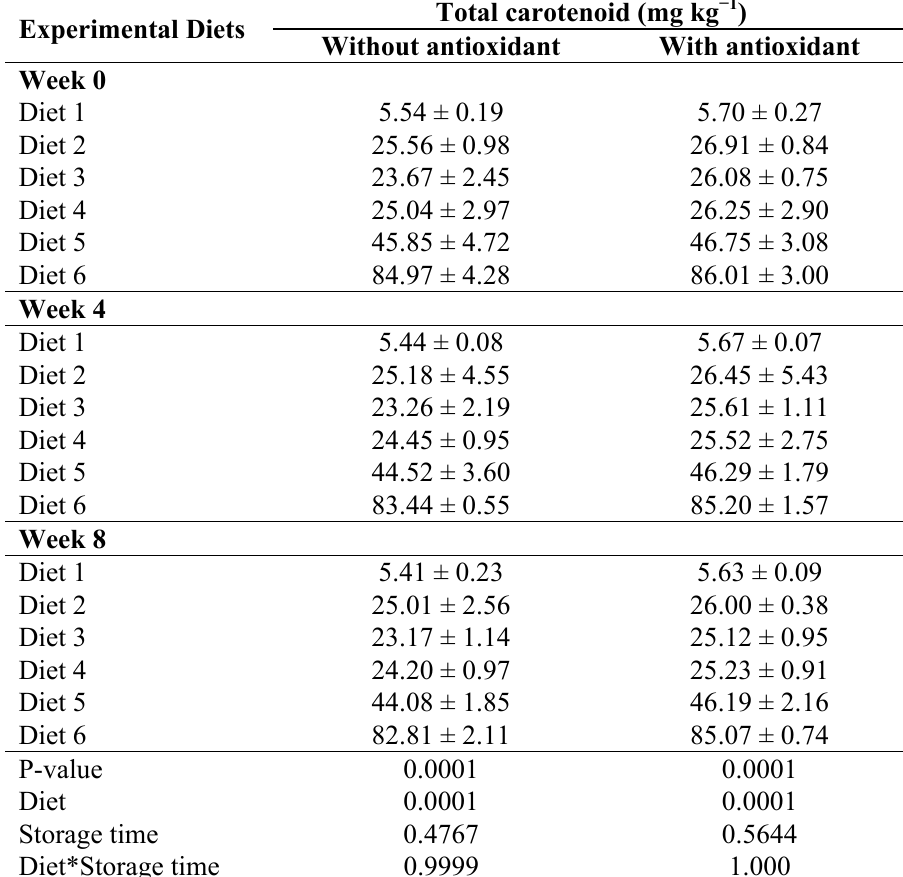
Table 4. Total carotenoids content in the experimental diets storage under 4 °C during the trial